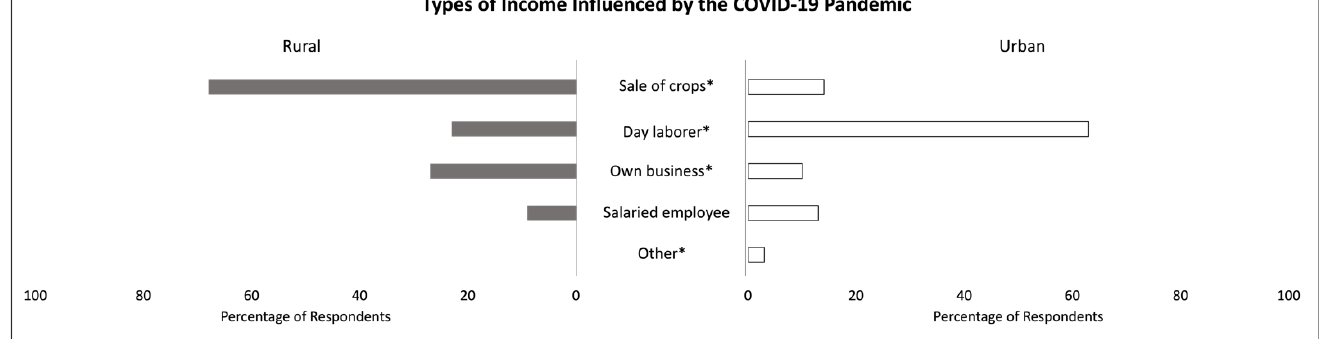
Figure 2. Reported impact of COVID-19 on various income sources in urban ( n = 144) and rural ( n = 173) Kenya. Multiple responses were recorded. * Statistically significant at p < 0.05 ( χ 2 test).